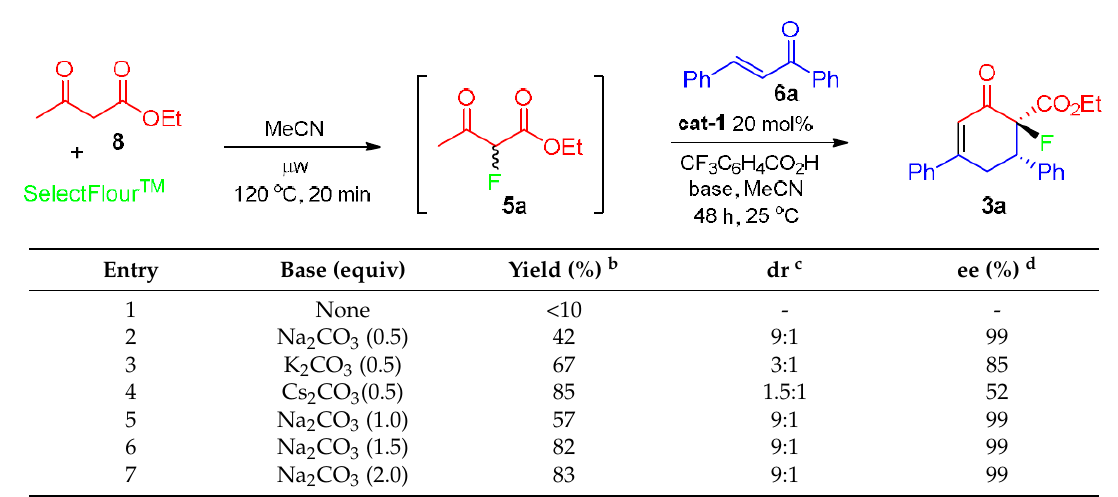
Table 2. One-pot synthesis of 6-fluorocyclohex-2-en-1-ones 3 a .